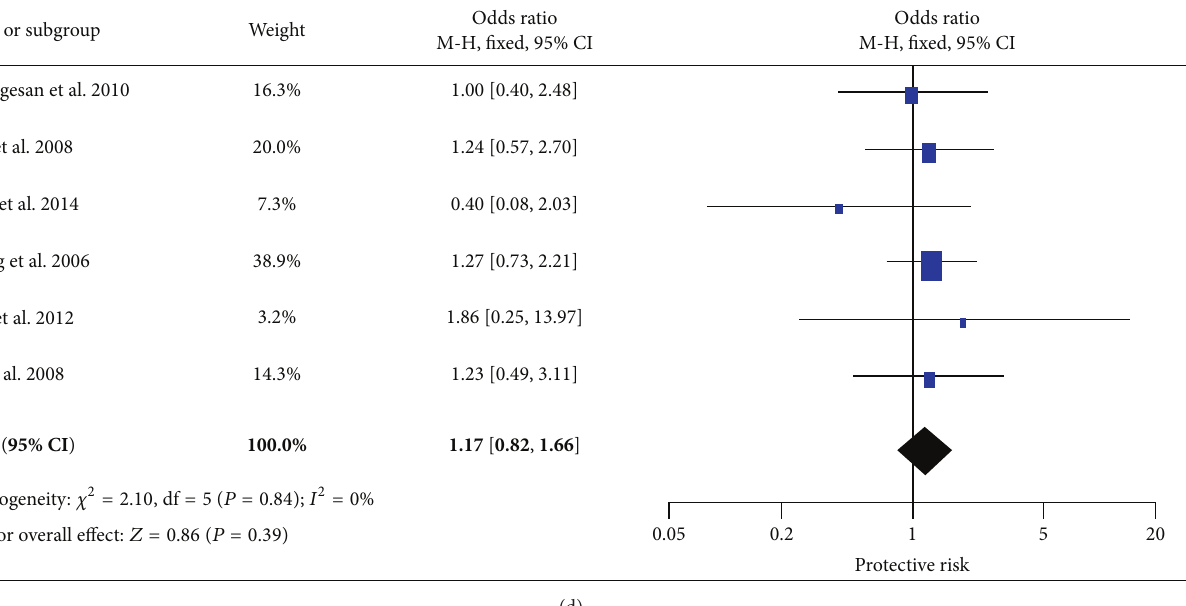
Figure 3: Forest plots of the association of LEPR p.R109K with T2DM. (a) Allele model, (b) dominant model, (c) homozygote model, and (d) recessive